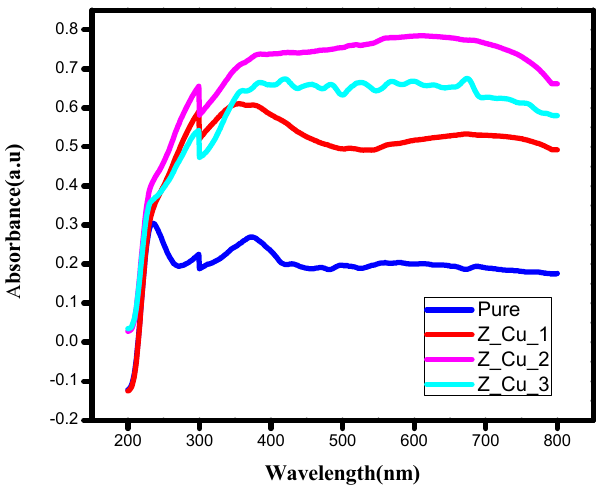
Fig. 4. UV - vis absorbance